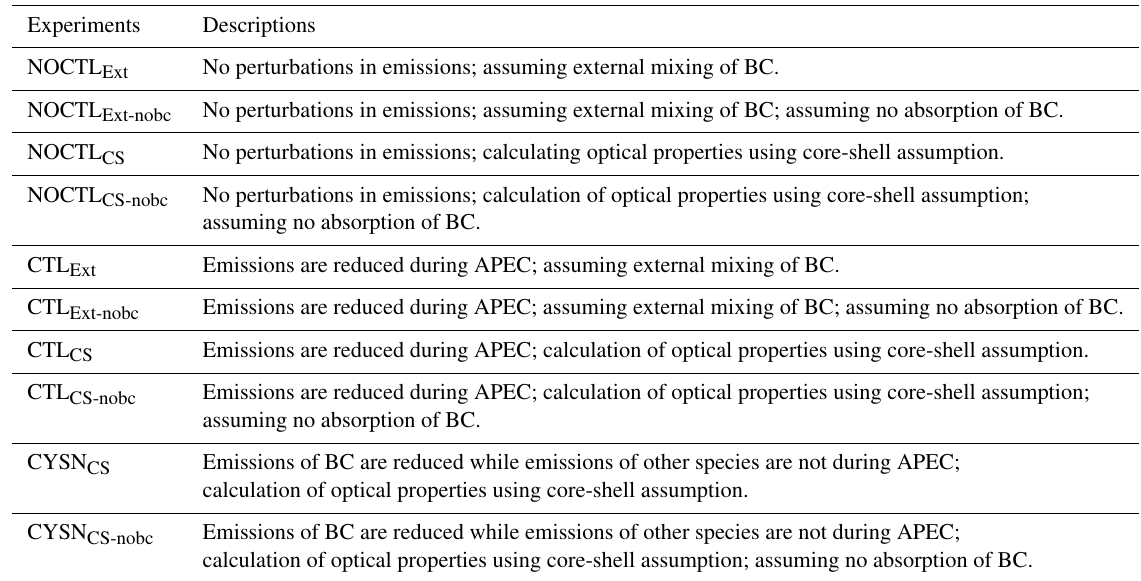
Table 1. Descriptions of model